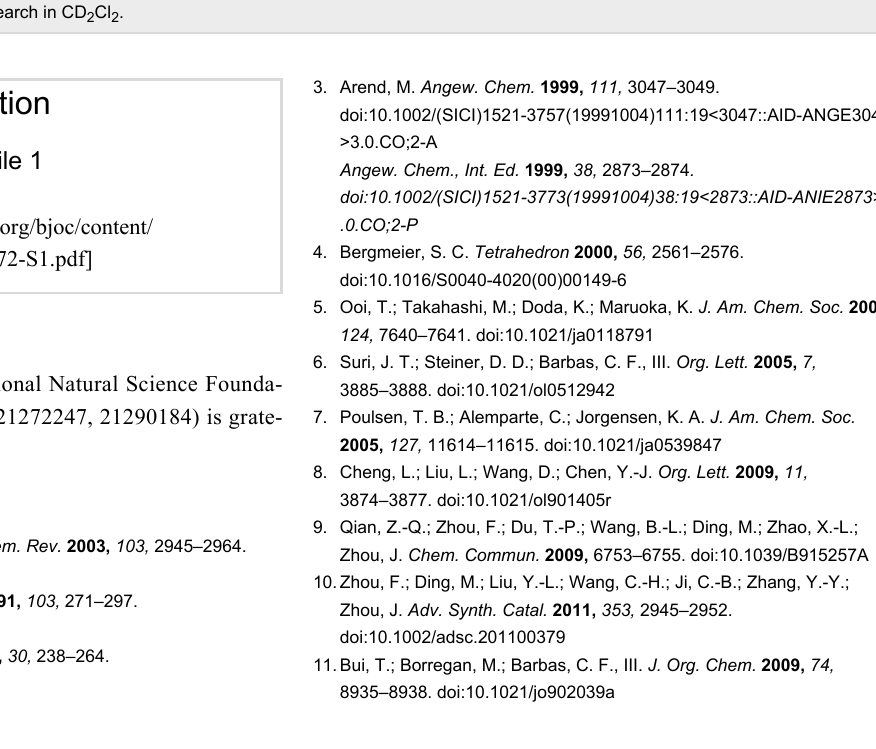
Figure 1: The 31 P NMR spectra research in CD 2 Cl 2